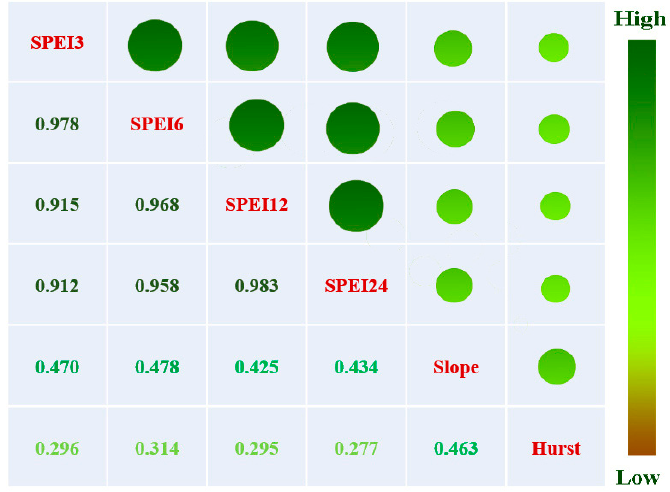
Figure 10. Pearson correlation coefficient of SPEI values and NDVI trend indicators in 39 meteorological stations. Table 4. The correlation coefficients of month change of NDVI and SPEI.